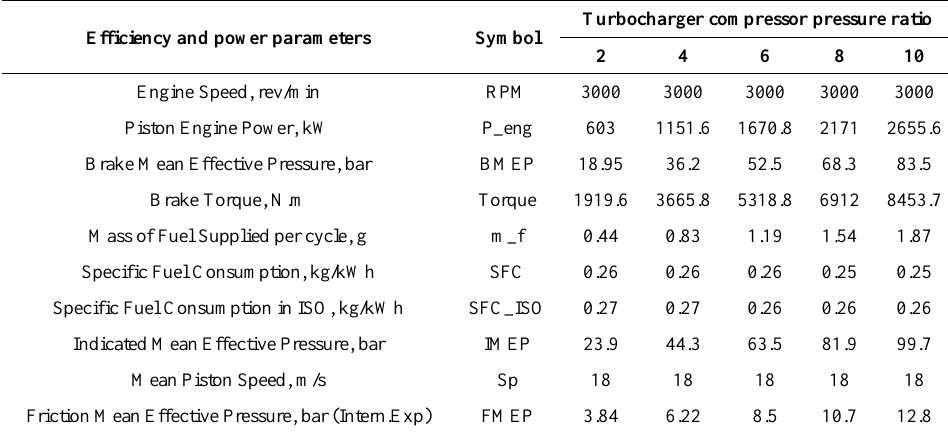
Table 1. Parameters of efficiency and